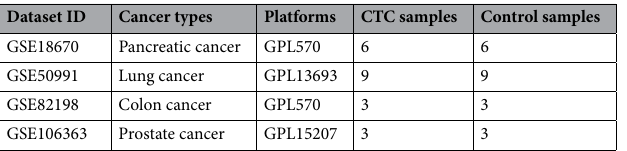
Table 1. Characteristics of the microarray databases derived from the GEO